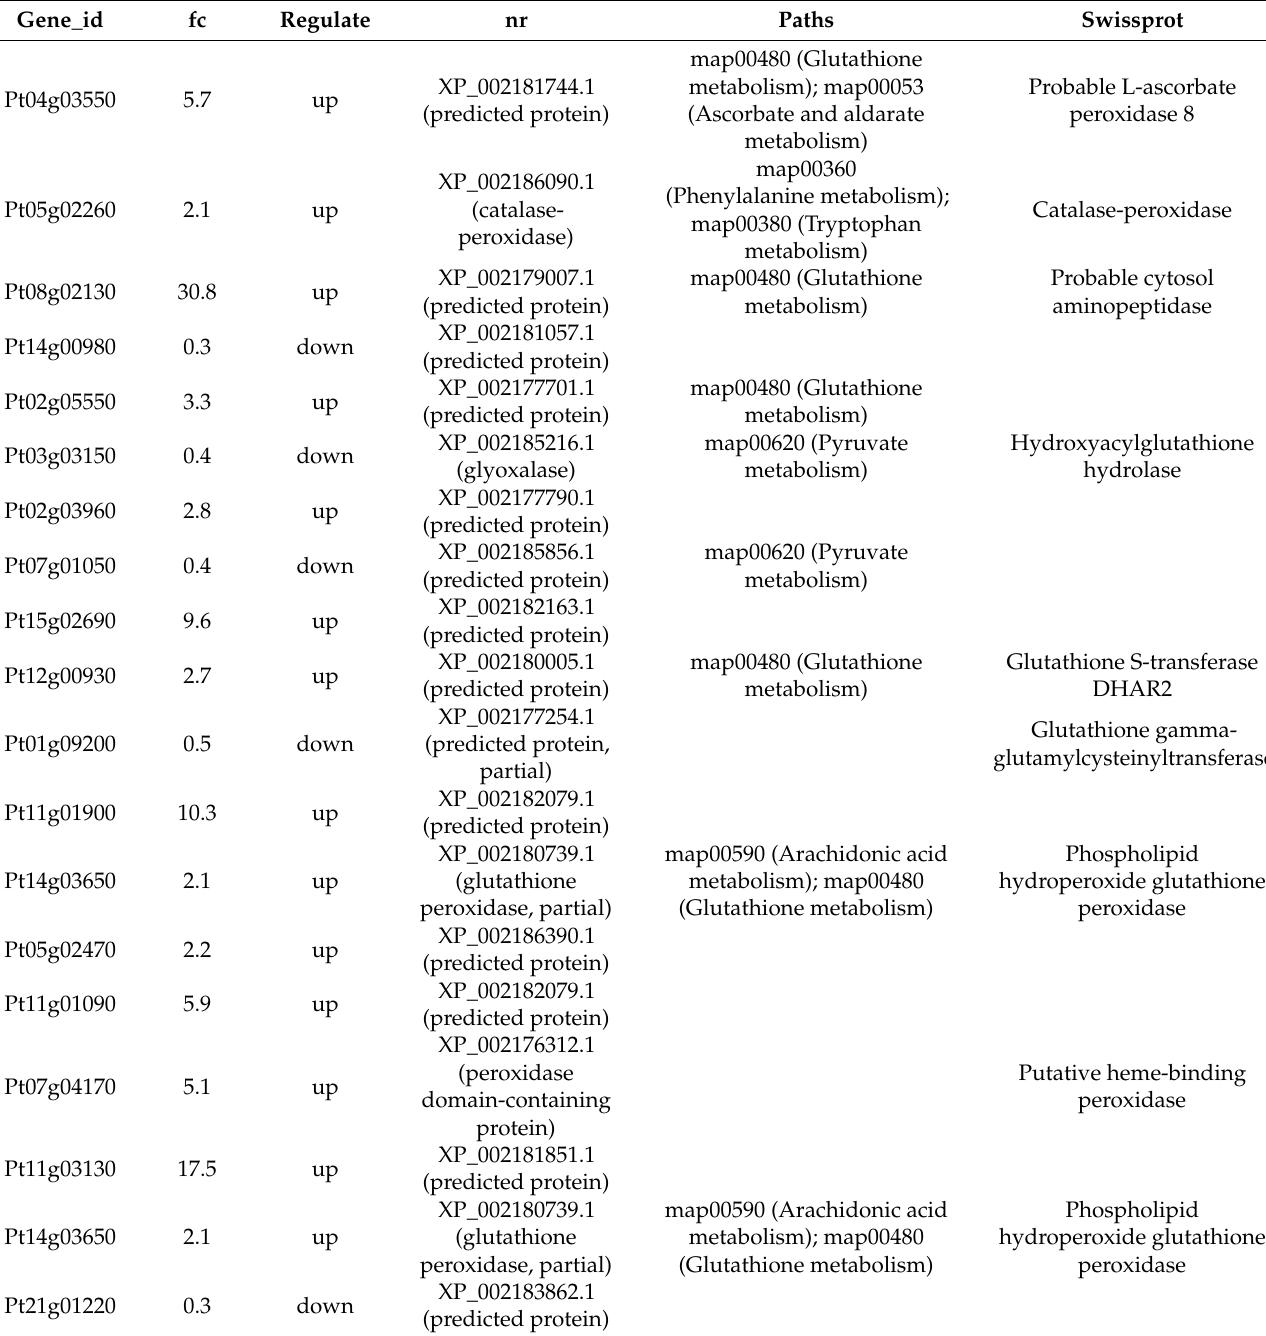
Table 1. DEGs involved in heavy metal stress response in P. tricornutum under Cu 2+